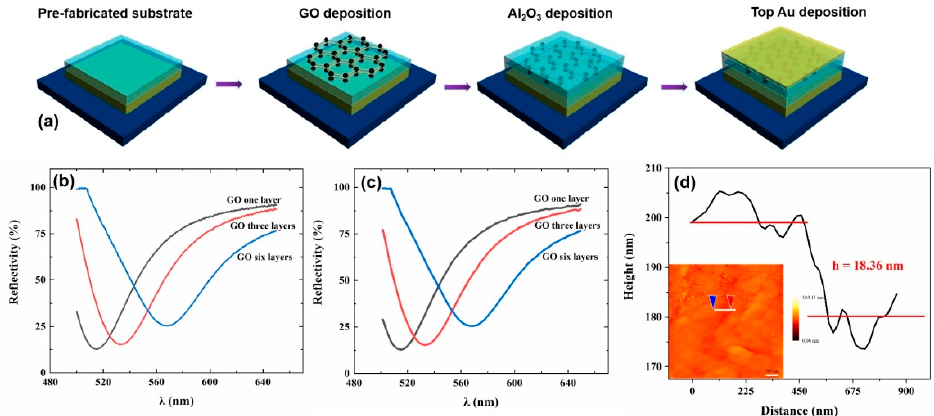
Figure 3. ( a ) The scheme of the GO integrated nanocavity fabrication process. ( b ) The measured reflection spectra for different layers of GO integrated nanocavity. ( c ) The simulated reflection spectra for different layers of GO integrated nanocavity. ( d ) The atomic force microscopy characterization of nine-layer graphene oxide.